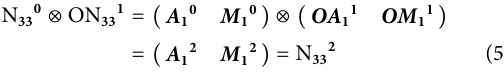
The logical matching process and method of the network object N 33 0 and the attack behavior object ON 33 1 are shown in Figure